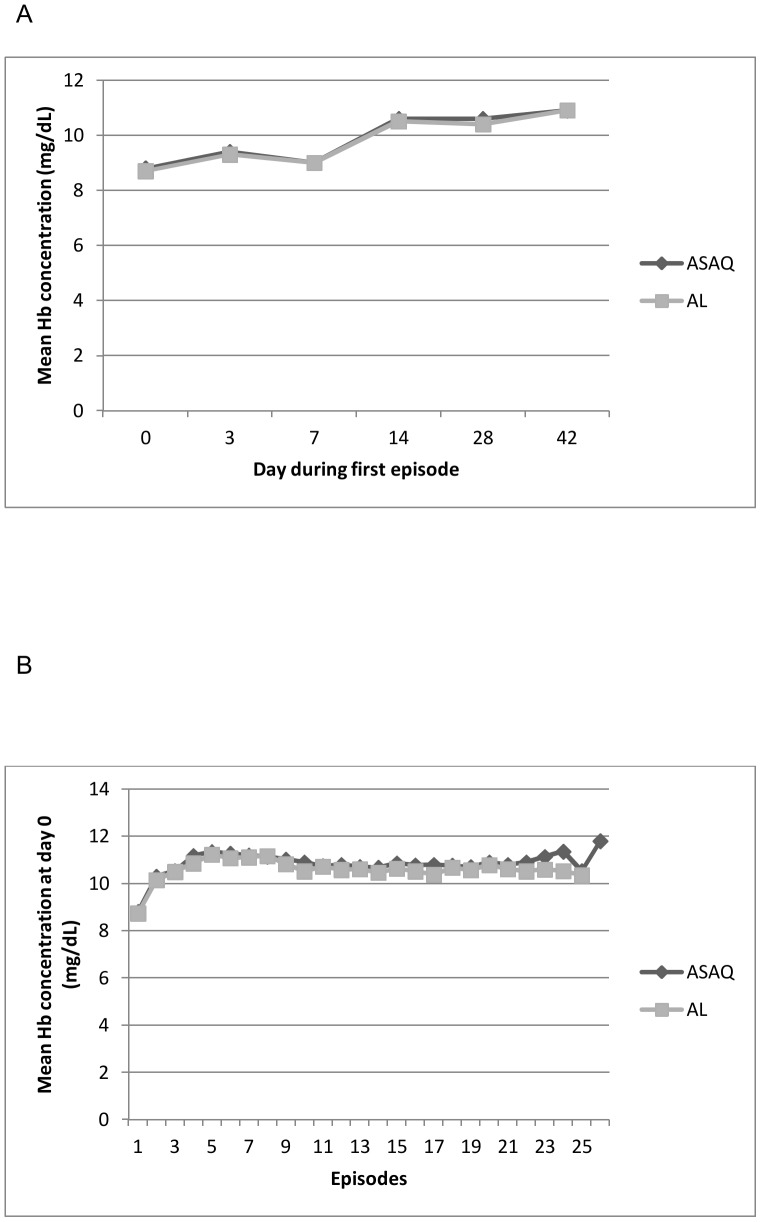
Blood Hb concentrations.Mean blood Hb concentrations in the ASAQ and AL groups between days 0 and 42 of the first episode (A) and on day 0 for all episodes (B). The dashed lined indicates the lower limit of the normal range for blood Hb concentration (10 mg/dL).